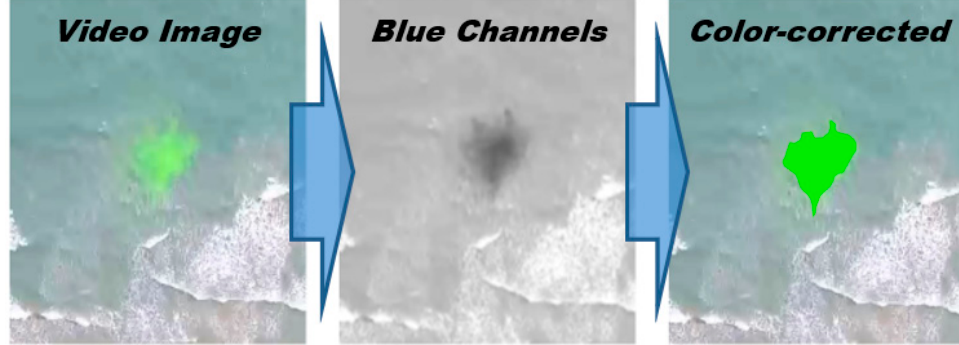
Figure 9. Color-correction process of fluorescein tracer dye.